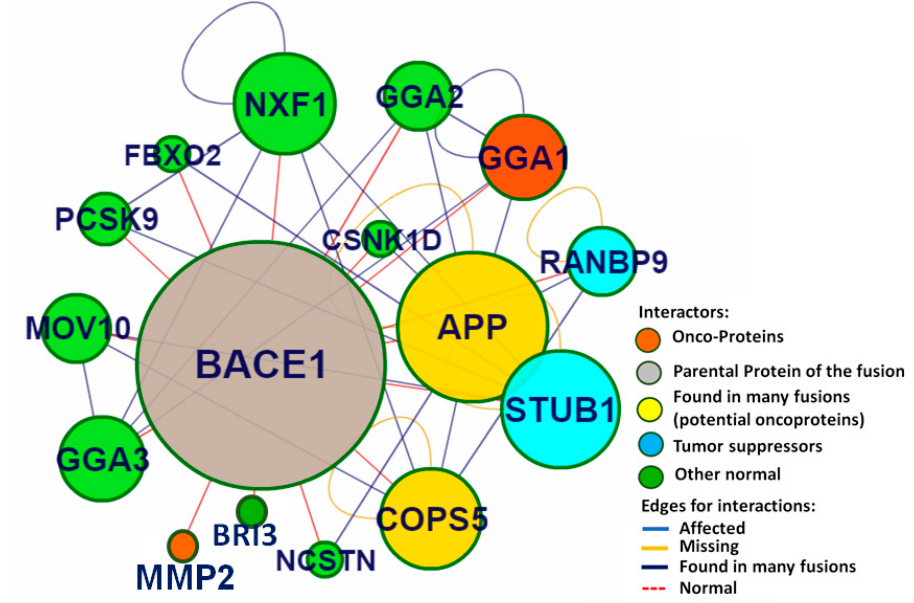
Figure 2. CHIPPI web server was used for the network protein-protein interaction (PPI) analysis.